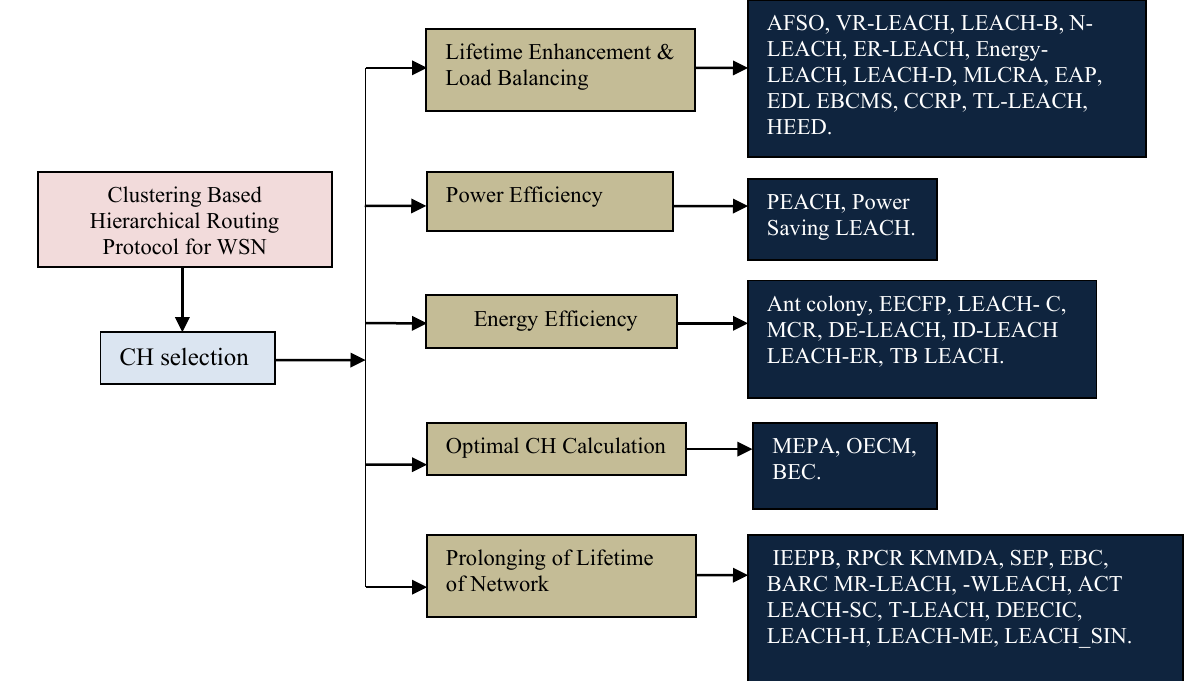
Figure 5. Multiple cluster head selection scheme and their protocol